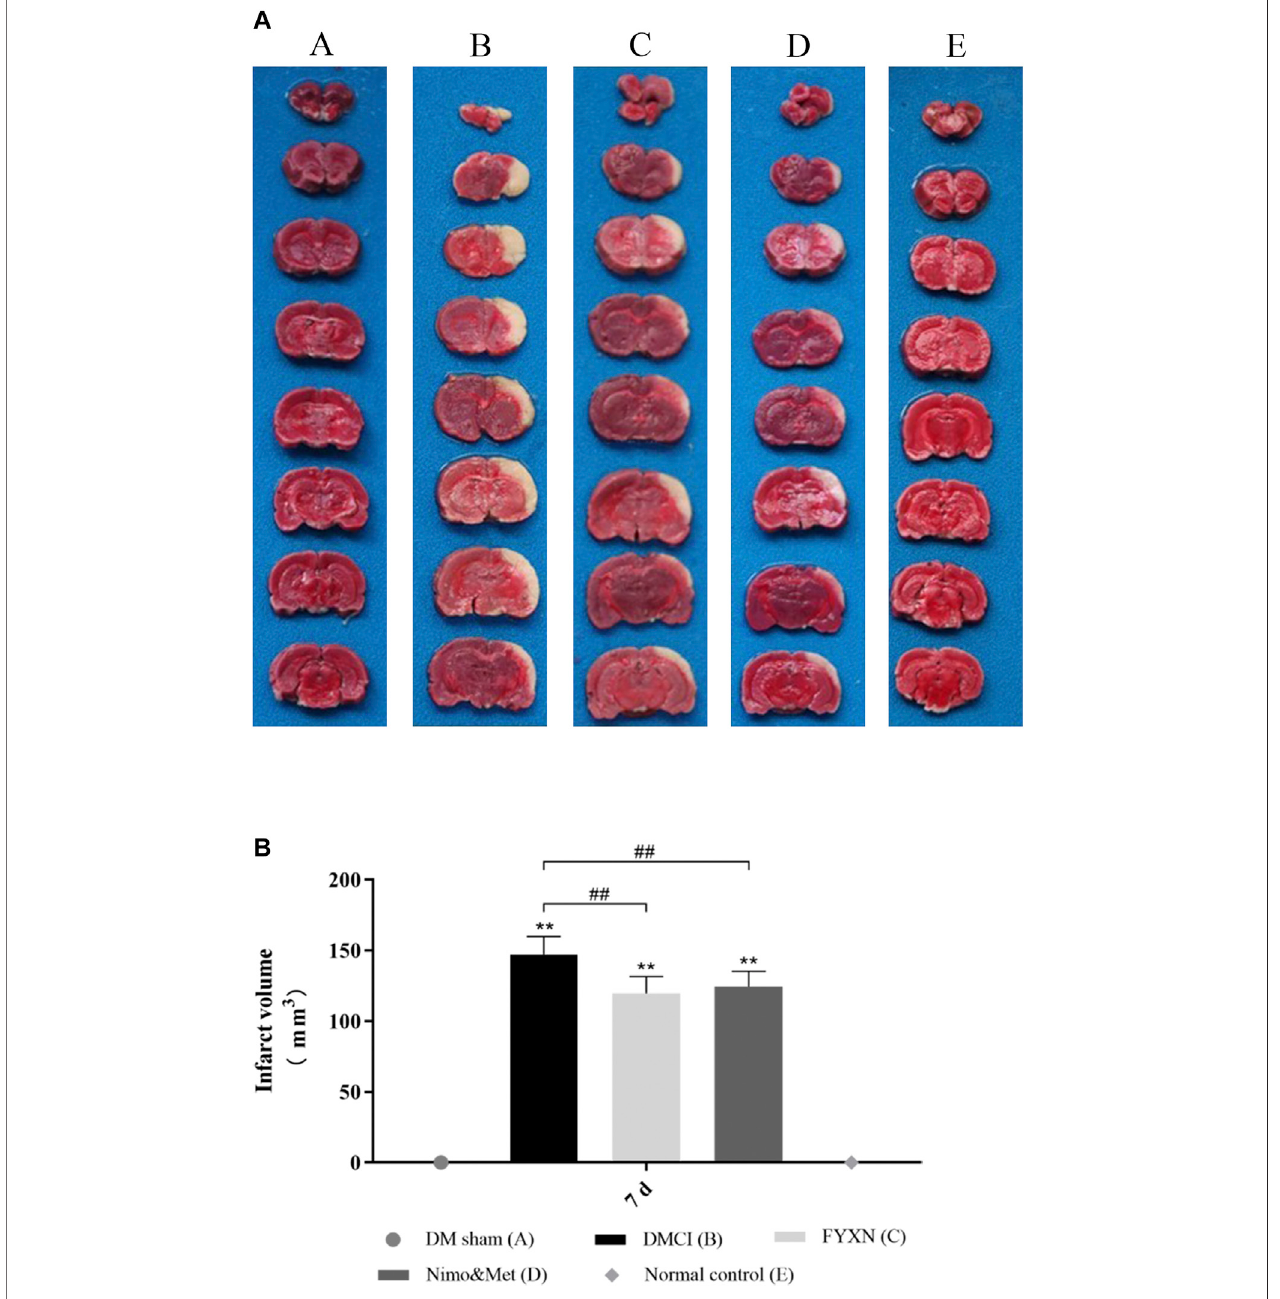
FIGURE 4 | (A) Focal cerebral infarct volume in the experimental groups after 7 days of ischemia followed by 7 days of treatment; 2,3,5-Triphenyltetrazolium chloride staining shows non-infarct (red) and infarct (white) regions. (B) Data of cerebral infarct volume are shown as mean ± SD in each group. * p < 0.05, ** p < 0.01 compared with NC group; # p < 0.05, ## p < 0.01 compared with DMCI